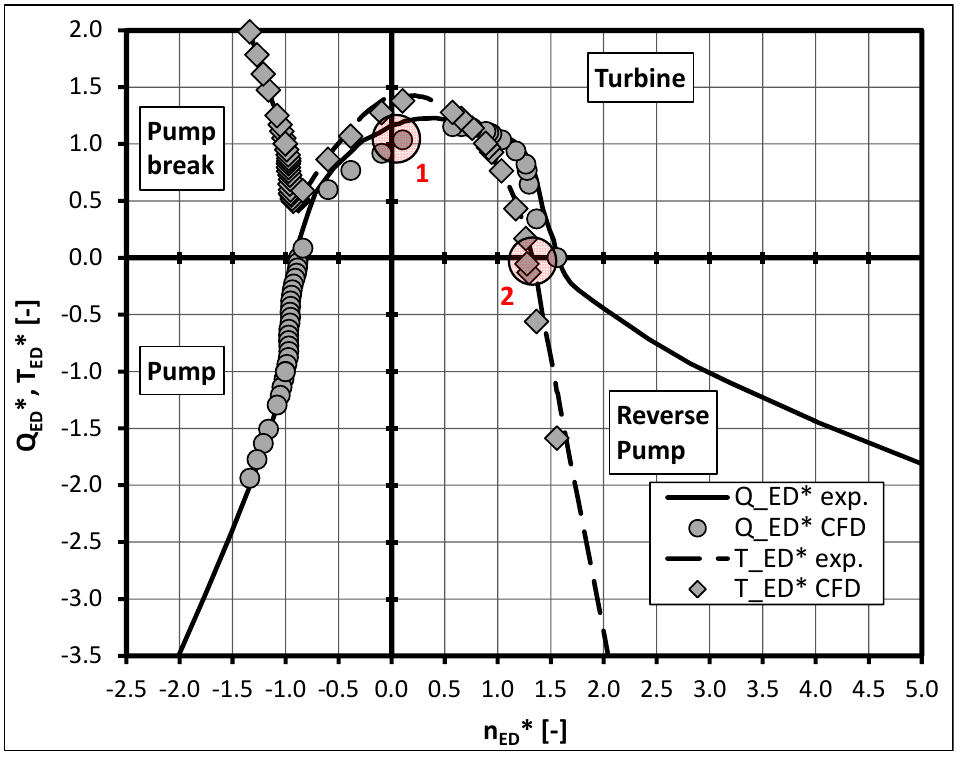
Figure 12. Four-quadrant curves: numerical results (markers) and experimental data (lines); low n q pump.